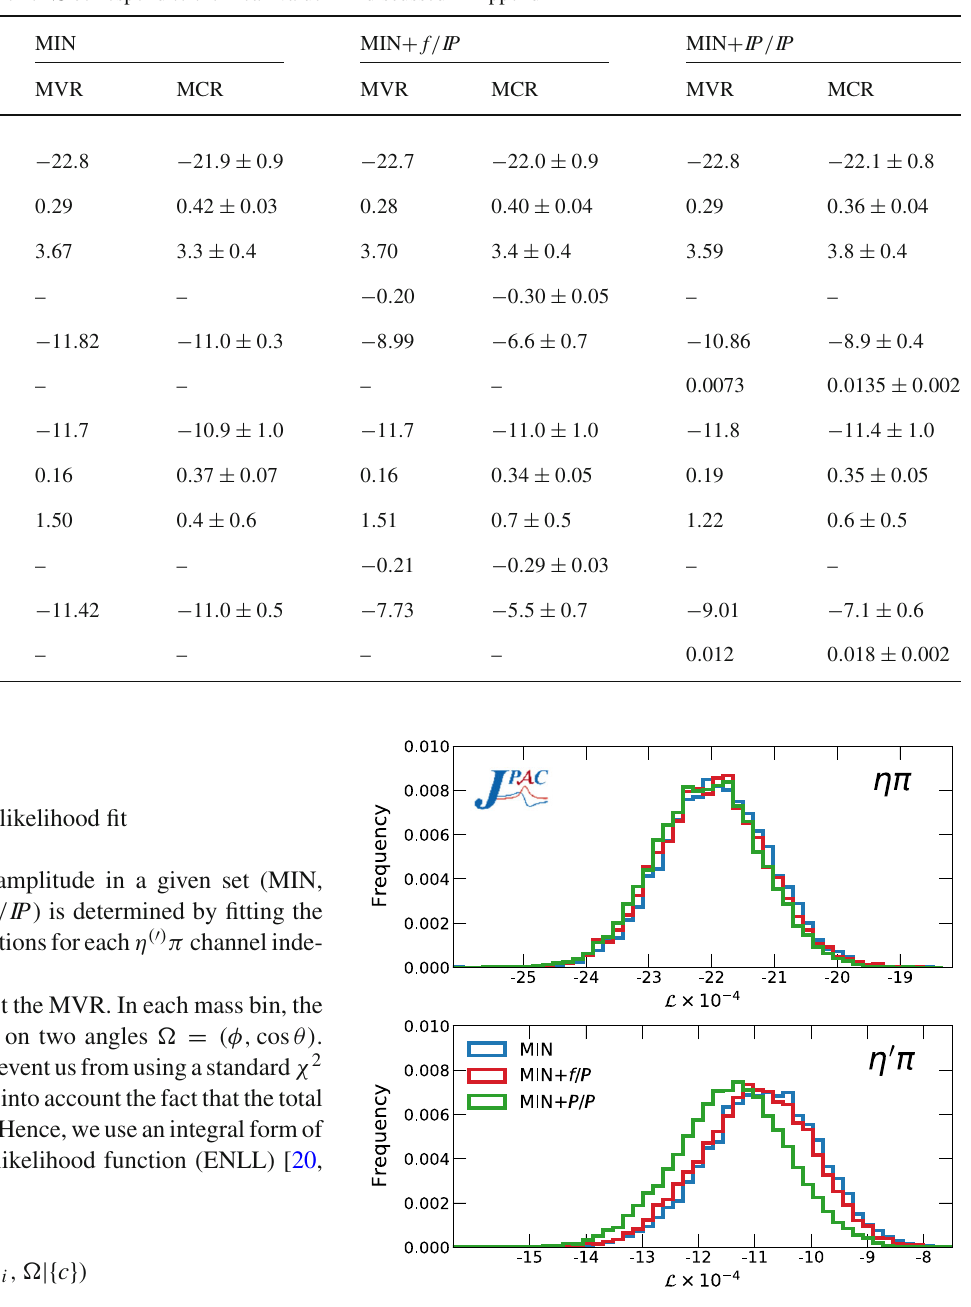
minimize L using MINUIT [43] to obtain the { c } parameters weighting each theoretical